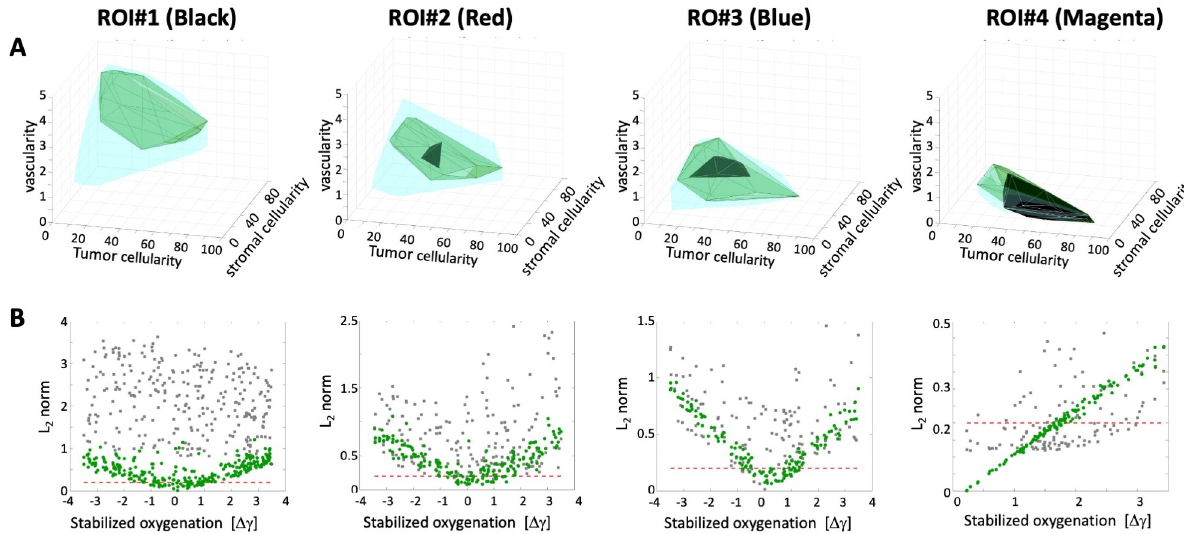
Fig 5. Robustness of optimal influx and uptake schedules. A. Parameter spaces of all tissues with oxygen levels within +/- 3.5 mmHg of the maximum experimental value for each ROI; 3D convex hulls shown in cyan, together with convex hulls for optimal influx schedule (green) and optimal uptake schedule (black) that fit experimental data with normalized L 2 -norm smaller than 0.2. B. Normalized L 2 -norms for influx schedule (green dots) and uptake schedule (grey dots) for each tissue from the cyan convex hull. The red dashed line represents the L 2 -norm value of 0.2. The results are shown from left to right for: ROI#1 (black), ROI#2 (red), ROI#3 (blue), and ROI#4 (magenta).